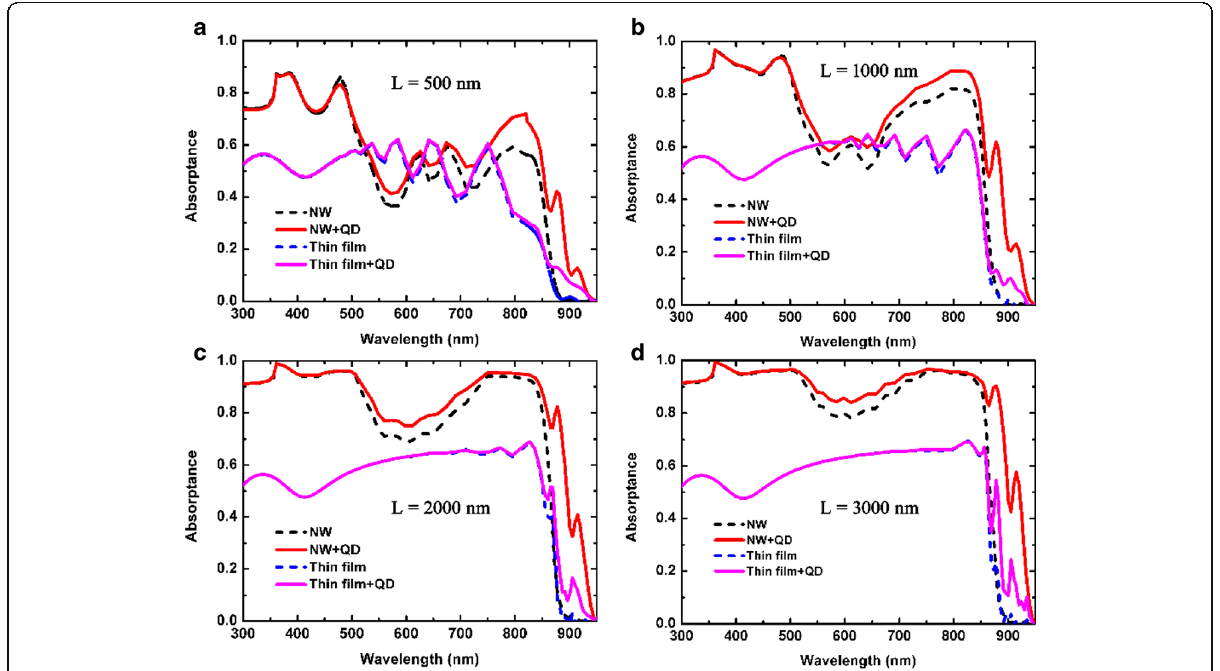
Fig. 3 The absorption spectra of the NW/QD hybrid nanostructure array and its thin-film counterpart with and without QD layers. The NW length in a – d is 500, 1000, 2000, and 3000 nm,